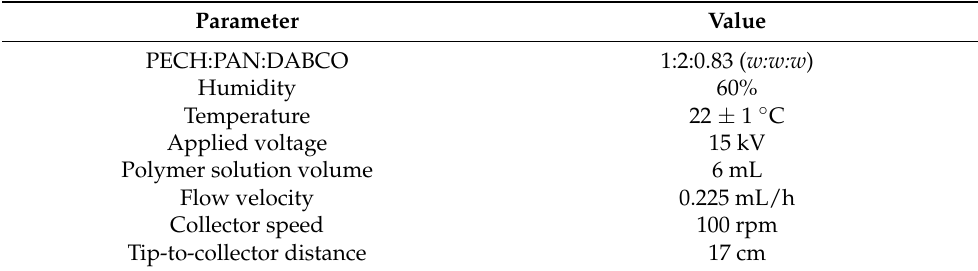
Table 2. Fixed electrospinning parameters that were used in this study as a